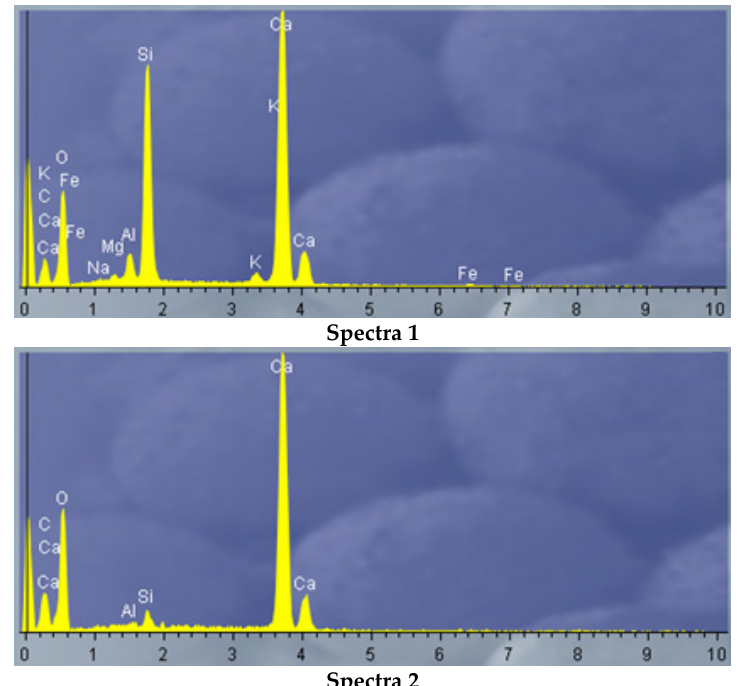
Figure 4. EDS spectra phases of the marl after thermal treating. The results of X-ray diffraction analysis (Figure 5) confirmed the presence in the ther- mally treated opoka-like marl samples of the peaks belonging to calcite, quartz, and a very small number of feldspars, most likely plagioclases. The peak at ~9 degreescorresponds to micas or hydromicas.